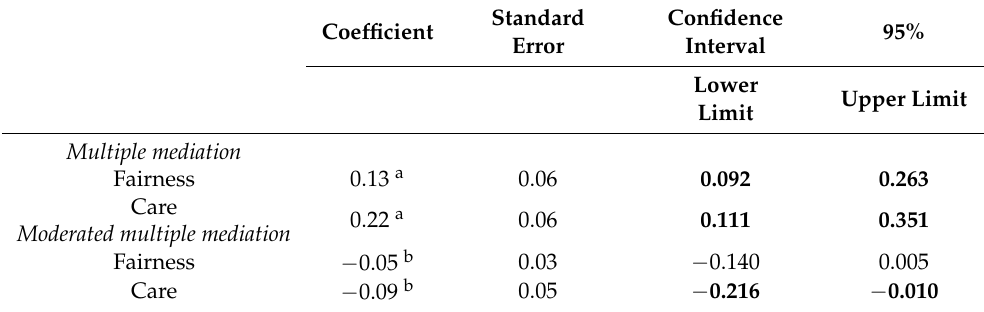
Table 4. Mediation and Moderation Effects Between Critical Motivation and Altruistic